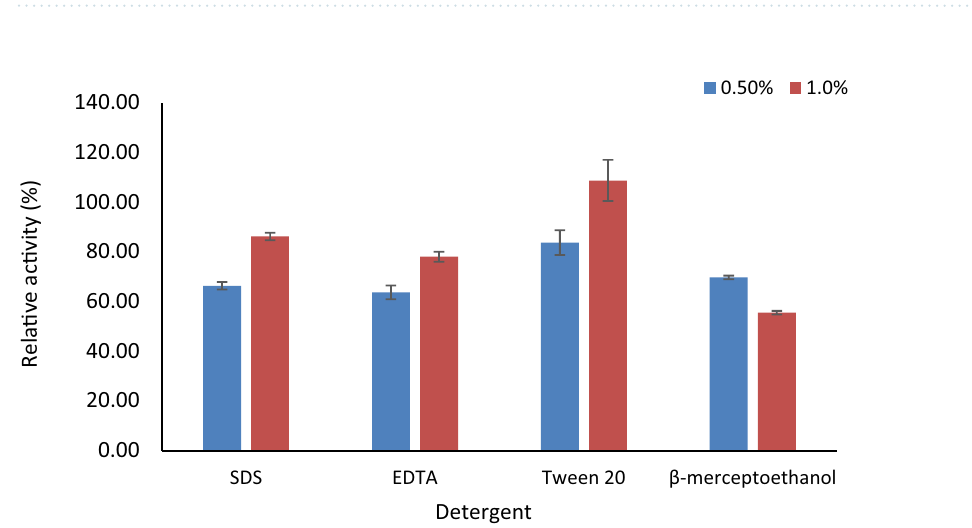
Figure 8. Effect of different detergents on pectate lyase activity from Paenibacillus lactis